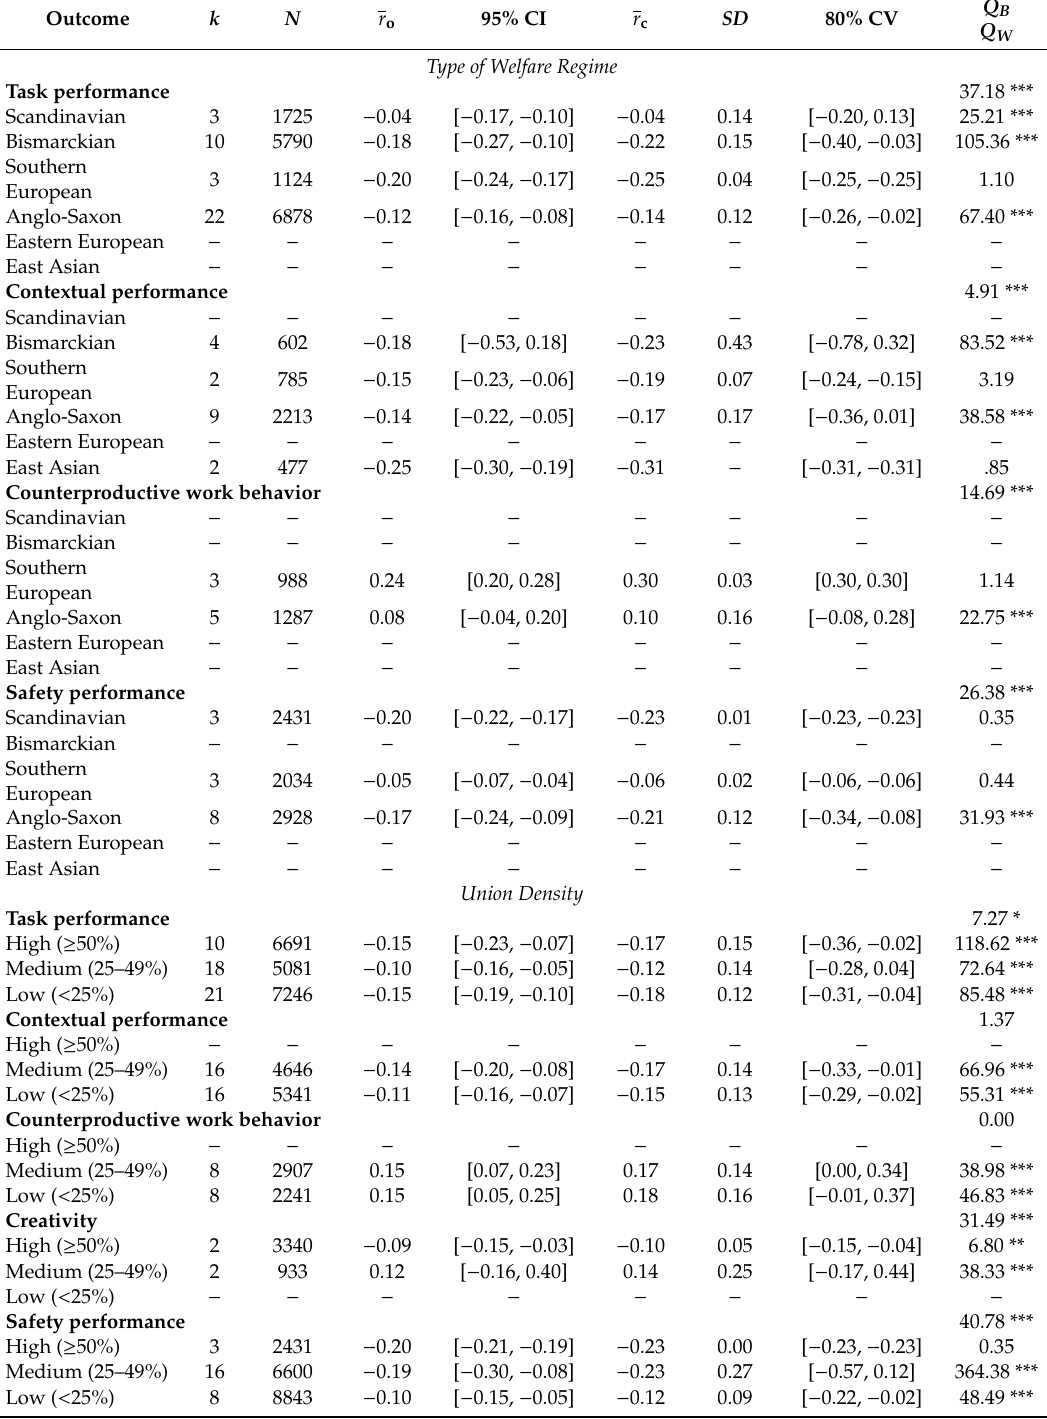
Table 4. Meta-analytic results by macro-level